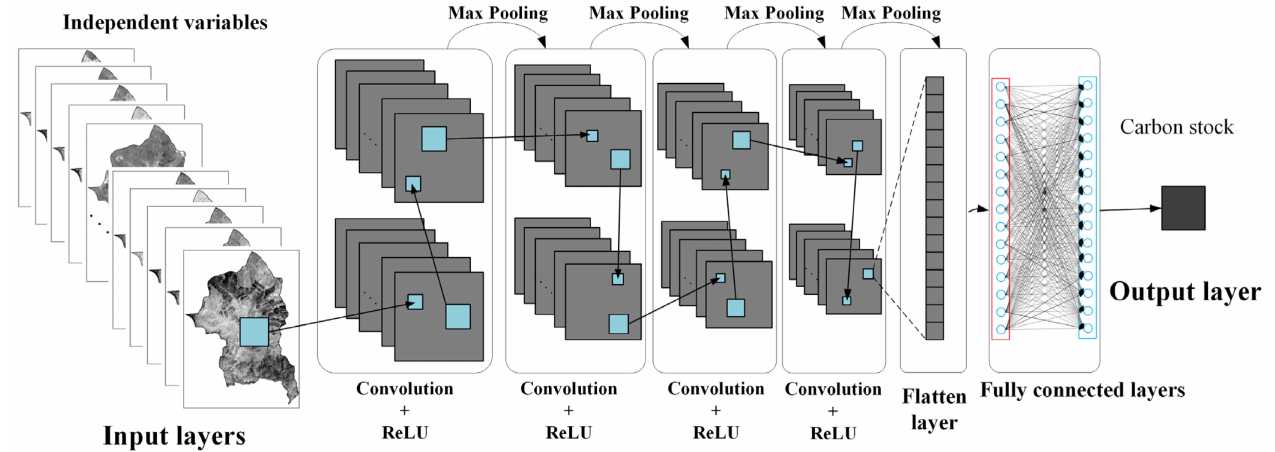
Figure 4. Schematic structure of the convolutional neural network model, including an input layer, a convolutional layer, a fully connected layer and an output